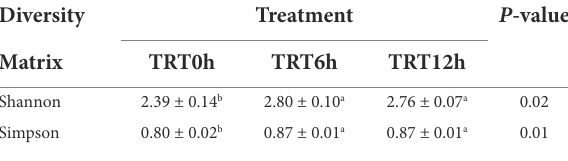
TABLE 1 Effect of delayed colostrum feeding on colon bacterial diversity (mean ±